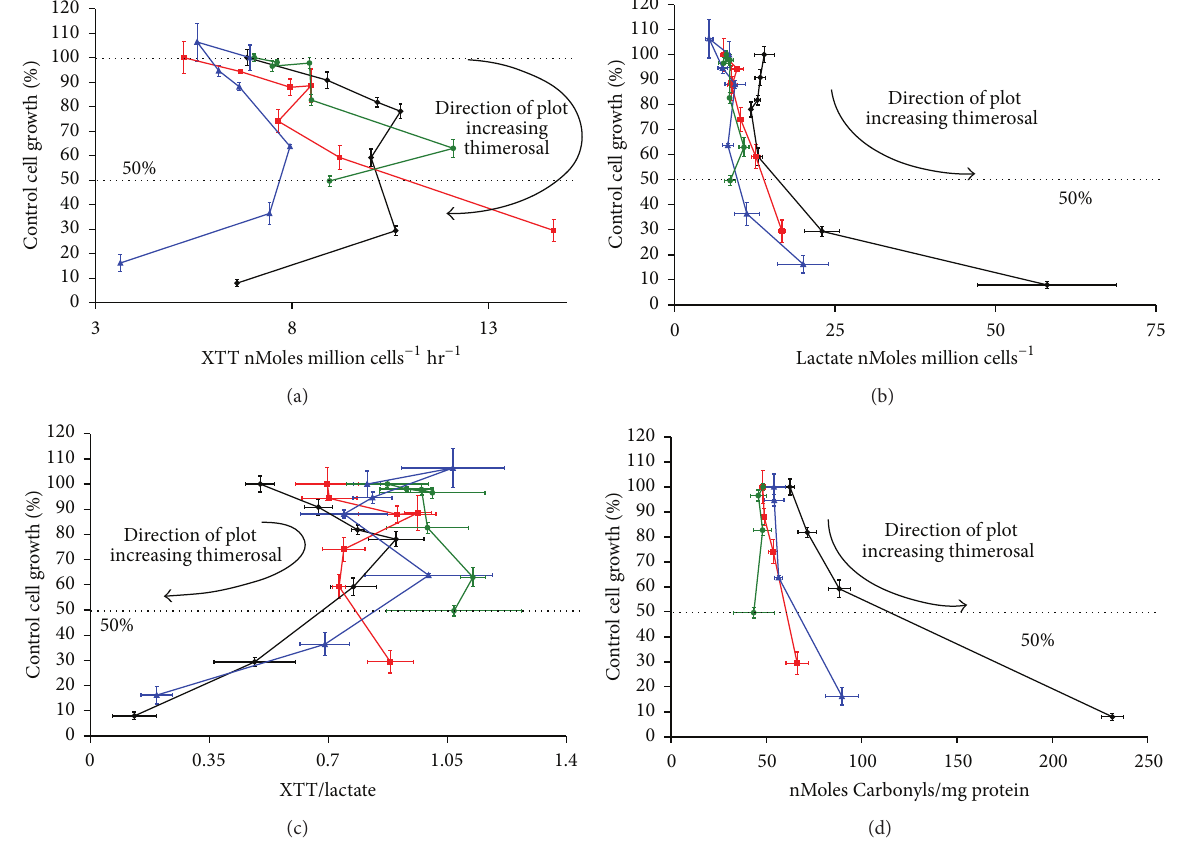
Figure 5: This figure shows data from Family B only, part of the same data set presented in Figure 1. (a) shows the rate of XTT reduction per million cells versus the % control cell growth for increasing thimerosal concentrations. (b) shows the rate of lactate production per million cells versus the % control cell growth for increasing thimerosal concentrations. (c) shows the XTT/lactate ratio versus % control cell growth for increasing thimerosal concentrations. (d) shows the amount of nMoles of carbonyl per mg of protein produced versus the % control cell growth for increasing thimerosal